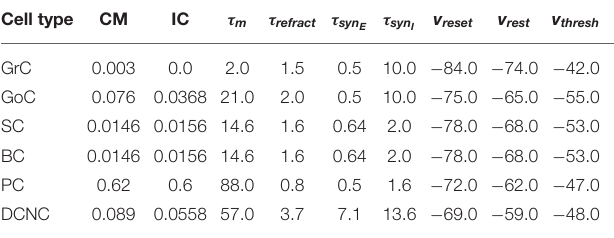
TABLE 2 | Cell and synapse parameters.